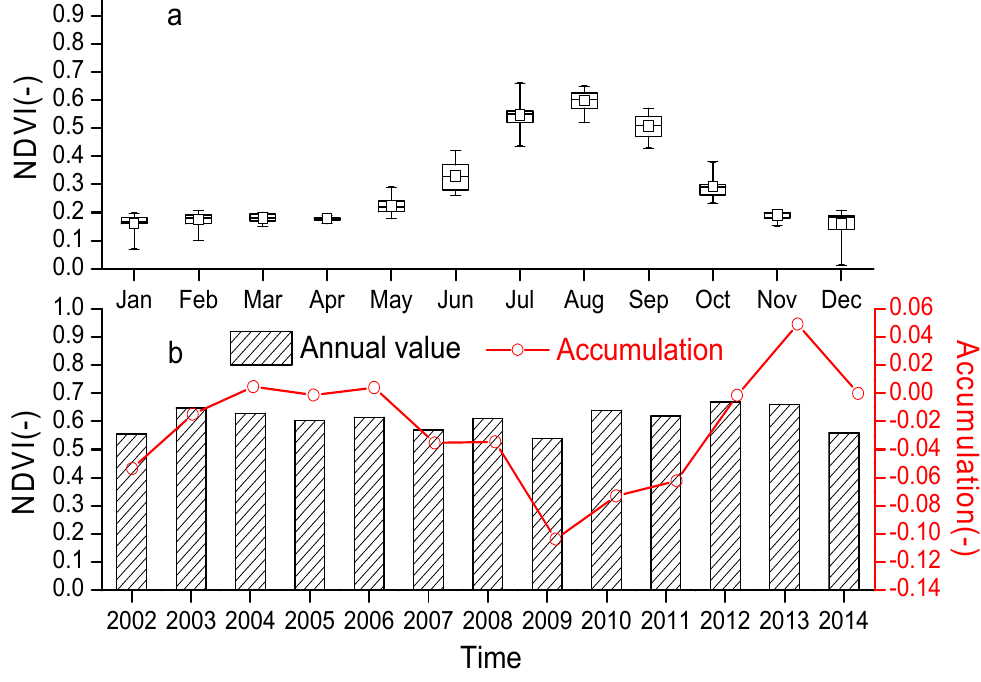
Figure 6. Variations ( a ) and curve of accumulation ( b ) of NDVI with time.